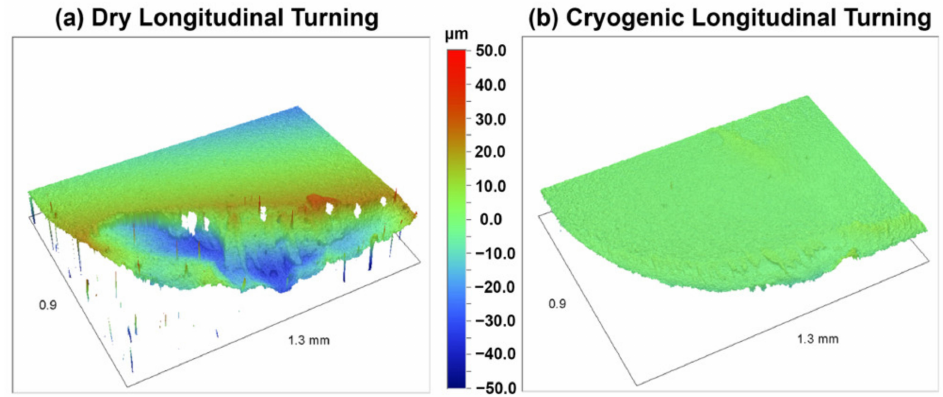
Figure 18. Topography worn volume difference between ( a ) dry and ( b ) cryogenic longitudinal